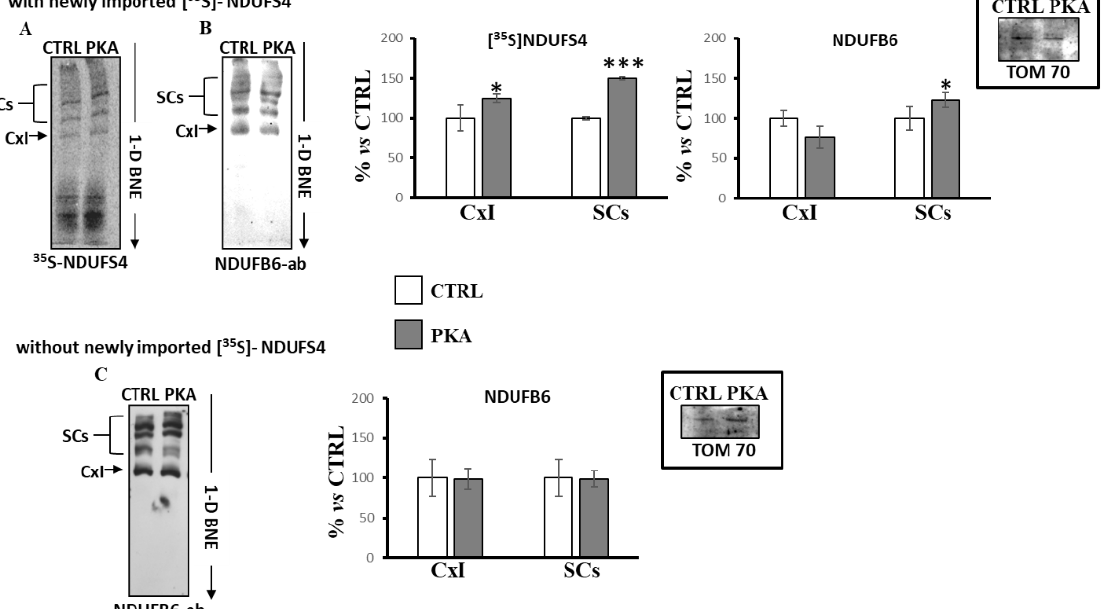
Figure 5. PKA addition to the mitochondrial import experiments increased the incorporation of [ 35 S]-Met labeled NDUFS4 in supercomplexes. Mitochondrial import experiments were performed in absence (CTRL) and in the presence of PKA (1 unit per 10 µg mitochondrial proteins) plus 7.5 mM sodium fluoride. After 60 min incubation at 30 °C, mitochondria were spun down from the import mixture after trypsin treatment (1 µg/50 µg mitochondrial proteins, 35 min on ice). The sol- ubilized pellets were analyzed by 1D-BNE and transferred into nitrocellulose. ( A ) Representative image of autoradiography of import experiment with RRL translation mixtures containing the newly synthesized [ 35 S]-Met labeled NDUFS4 protein. ( B ) Representative image of immunoblotting analysis with a specific antibody against the NDUFB6 subunit of complex I of import experiment with RRL translation mixtures containing the newly synthesized [ 35 S]-Met labeled NDUFS4 protein. ( C ) Representative image of immunoblotting analysis with a specific antibody against the NDUFB6 subunit of complex I of import experiment with RRL translation mixtures without the newly syn- thesized [ 35 S]-Met labeled NDUFS4 protein. The histograms represent the percentage of ADU of PKA-treated samples with respect to untreated samples (CTRL) of radioactive bands ([ 35 S]-Met NDUFS4) and immuno-revealed bands (NDUFB6) in free complex I (CxI) and in SCs. The values are the means ± SD of three different experiments. (PKA vs. CTRL, * p < 0.05, *** p < 0.001, Student’s t -test). The insets represent the loading controls performed using TOM 70 antibody after the SDS- PAGE. For more details, see under Materials and Methods.